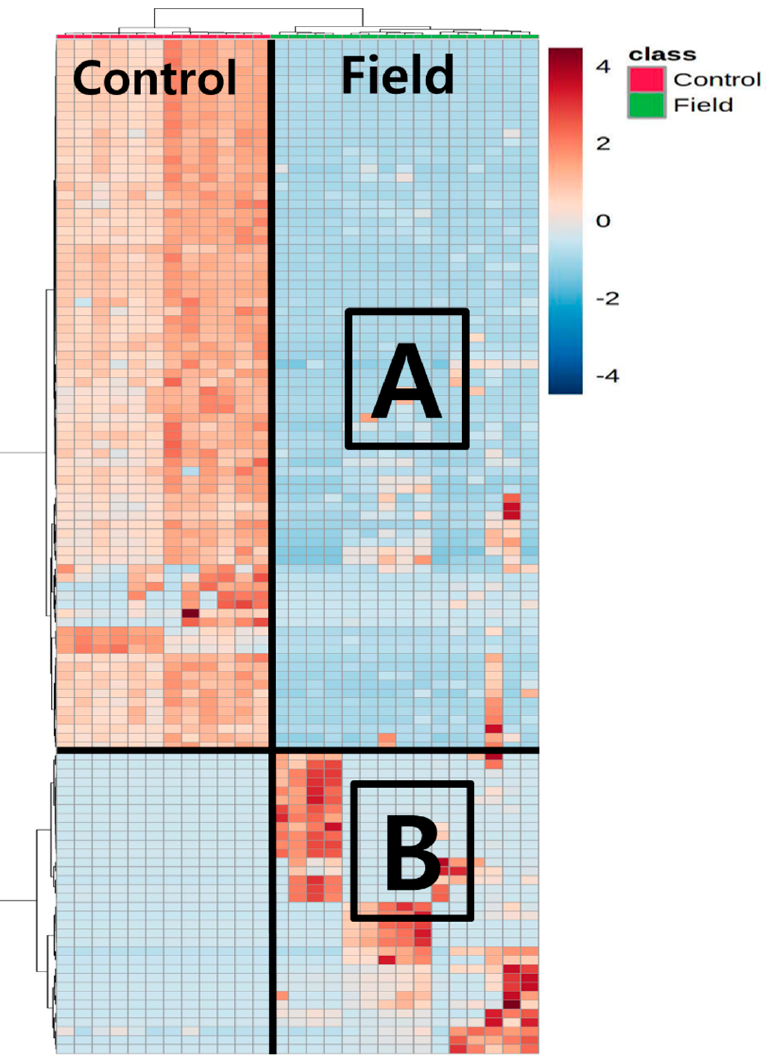
Figure 4. Heat map visualization of control (not contaminated soil) and field (contaminated soil); a total of 114 variables shown in heat map filtered by p -value < 0.05 through t-test. Metabolites in A site means downregulation of metabolism due to soil contamination and metabolites in B site means upregulation of metabolism due to soil contamination. The metabolites shown in heat map analysis are suggested in Table 4.